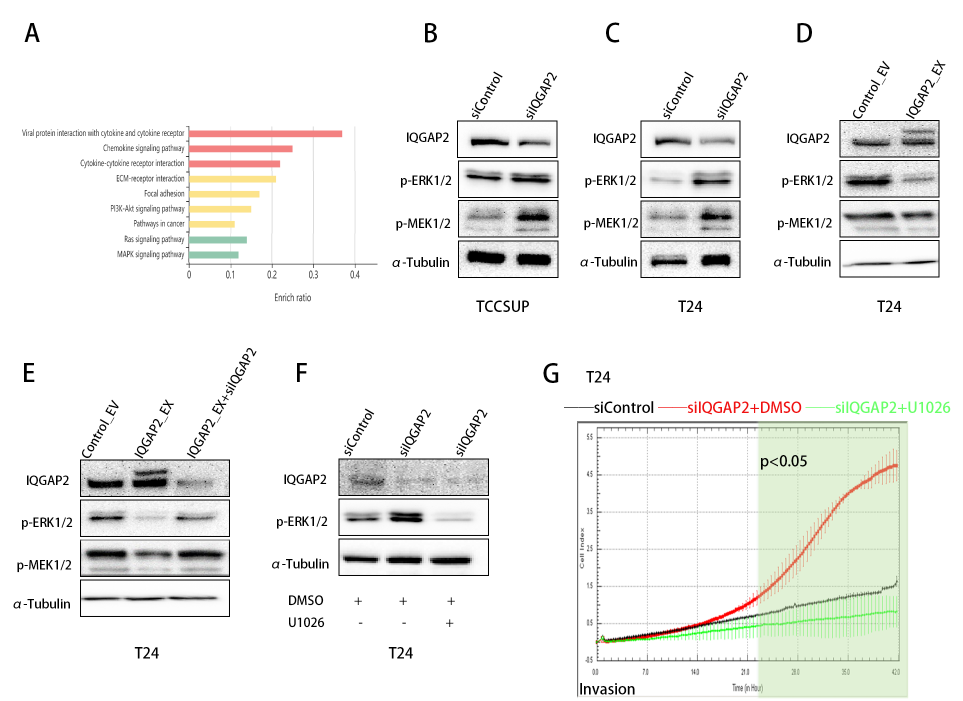
Figure 6. IQGAP2 regulated EMT via activation of MAPK/ERK pathway. ( A ) KEGG pathway analysis (http://kobas.cbi.pku.edu.cn/ accessed on 29 November 2021) of IQGAP2 and its co- expressed genes in bladder cancer identified by cBioPortal co-expression analysis using bladder cancer TCGA dataset (www.cbioportal.org accessed on 29 November 2021). ( B , C ) Western blot showing elevated phospho-MEK1/2 and phospho-ERK1/2 in TCCSUP and T24 after IQGAP2 knockdown. ( D ) Western blot showing decreased phospho-MEK1/2 and phospho-ERK1/2 in T24 after IQGAP2 overexpression. ( E ) Western blot showing rescue of phospho-MEK1/2 and phospho- ERK1/2 in T24_IQGAP2_EX with IQGAP2 depletion compared with control. ( F ) Western blot showing rescued phospho-ERK after treating IQGAP2-depleted (IQGAP2_KD) T24 with phospho- ERK inhibitor U0126. ( G ) Cell invasion assay after treating IQGAP2-depleted (IQGAP2_KD) T24 with phospho-ERK inhibitor U0126. Bar chart presents the meansof replicates ± SEM from three different experiments; Student’s t -test (two-tailed, unpaired) was used for comparison of